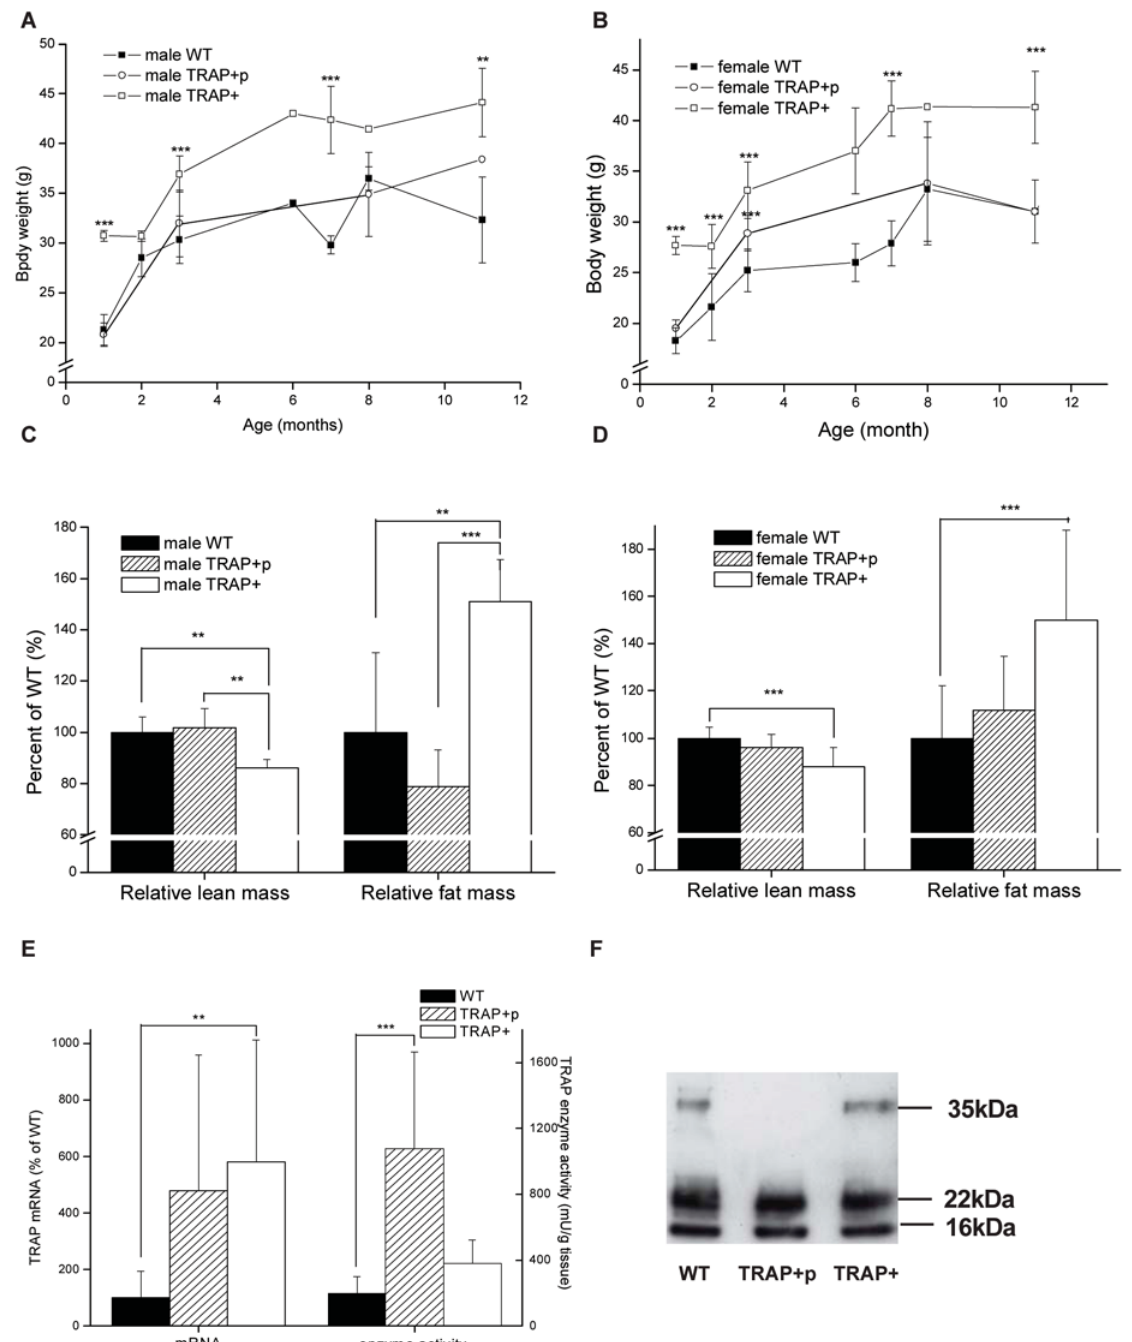
Figure 2. Over expression of monomeric TRAP is associated with obesity in transgenic mice. (A) Growth curve of male obese TRAP + (open square), lean TRAP + p (open circle) and WT (black square) mice. (B) Growth curve of female obese TRAP + (open square), lean TRAP + p (open circle) and WT (black square) mice. (C) Relative lean and fat mass in male WT, TRAP + p and TRAP + mice. (D) Relative lean and fat mass in female WT, TRAP + p and TRAP + mice. (E) Expression of TRAP mRNA and enzyme activity in adipose tissue from WT, TRAP + p and TRAP + mice. (F) Western blot of TRAP in adipose tissue from WT, TRAP + p and TRAP + mice.